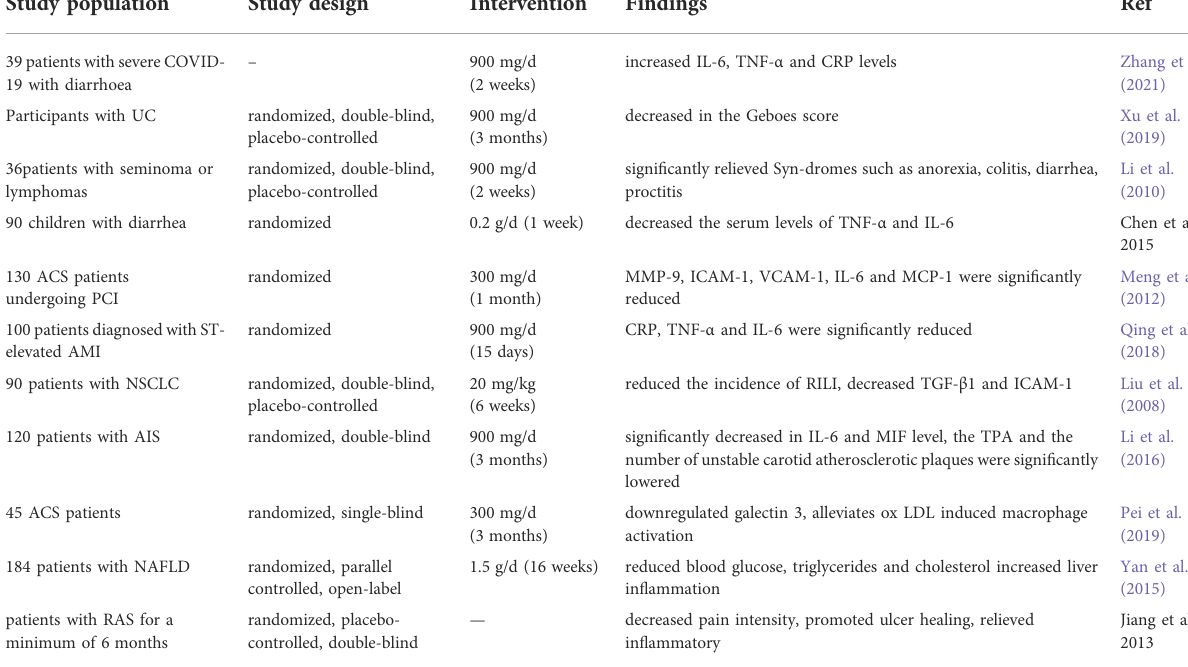
TABLE 4 Clinical application of